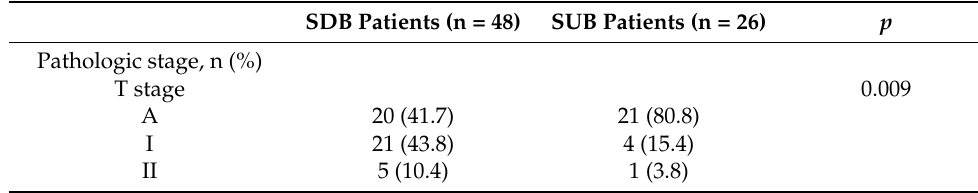
Table 2. Pathology findings after transurethral resection of bladder tumors of screen-detected bladder cancer and screen-undetected bladder